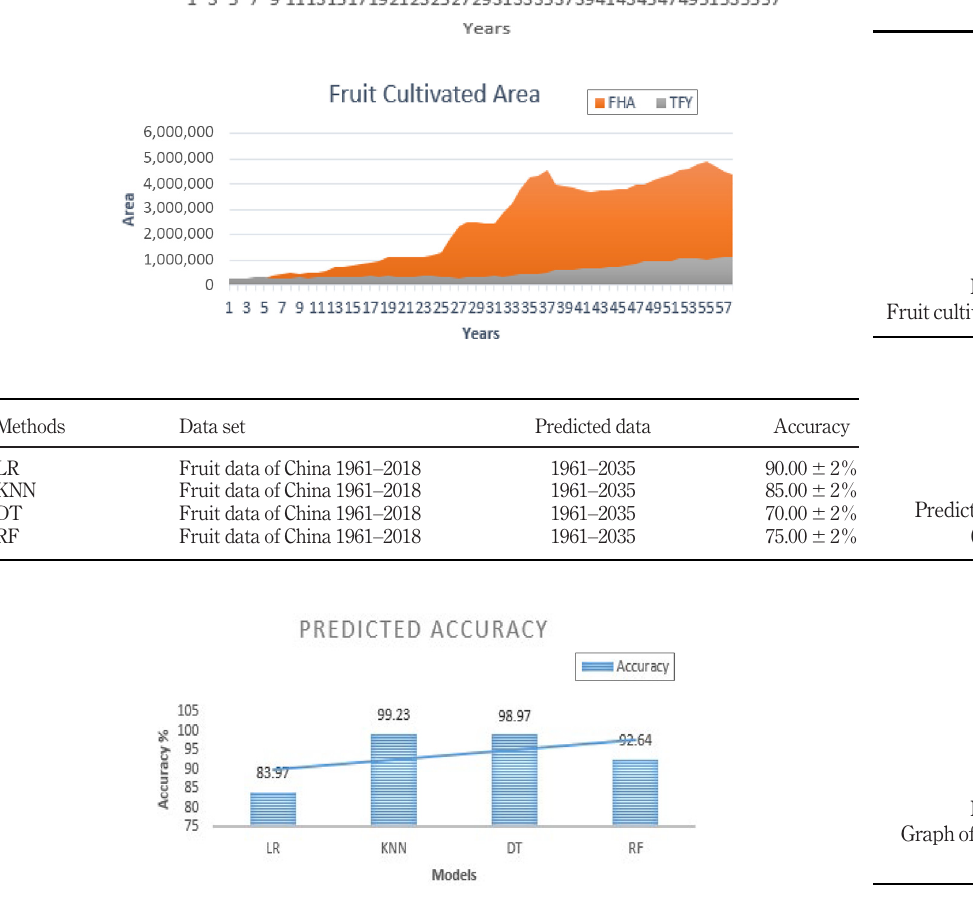
Figure 6. Agriculture labor